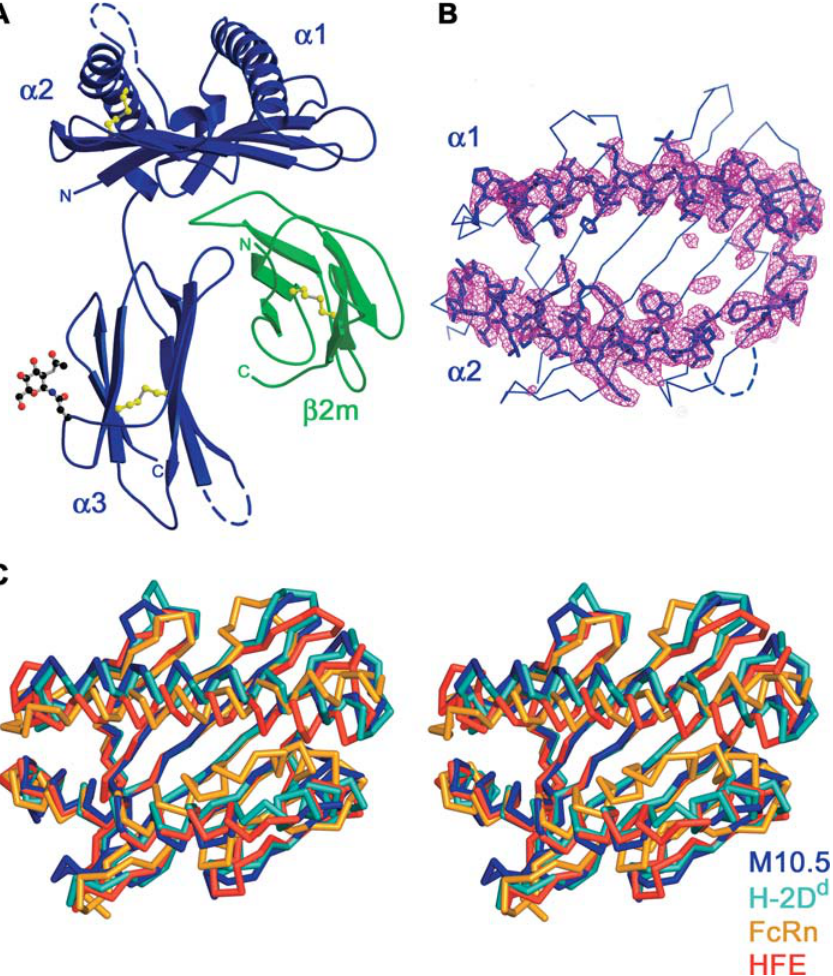
Figure 1. The Structure of M10.5 (A) Ribbon diagram of M10.5 (side view). The heavy chain is blue, the b 2m light chain is green, disulfide bonds are yellow, and ordered carbohydrate attached to Asn223 is shown in ball-and-stick representation. Two disordered loops in the heavy chain are shown as dashed blue lines. (B) Top view of the a 1– a 2 platform overlaid with an F o -F c annealed omit electron-density map contoured at 3.5 r . The map was calculated for one of five molecules in the asymmetric unit using NCS restraints in the annealing process. Residues 55–84 and 137–174, shown in stick representation, were omitted from the structure factor calculation. Electron density is absent for residues 145–150 (dashed line), indicating that they are disordered. No significant electron density is observed in the groove between the a 1 and a 2 helices. (C) Stereo view of the superposition of the a 1– a 2 platforms from M10.5, H-2D d [24], FcRn [32], and HFE [33]. Structures were aligned using residues classified as platform b -sheet residues (see Materials and Methods). The cleft between a 1 and a 2 helices is significantly narrower in FcRn and HFE than in M10.5 and H-2D d . DOI: